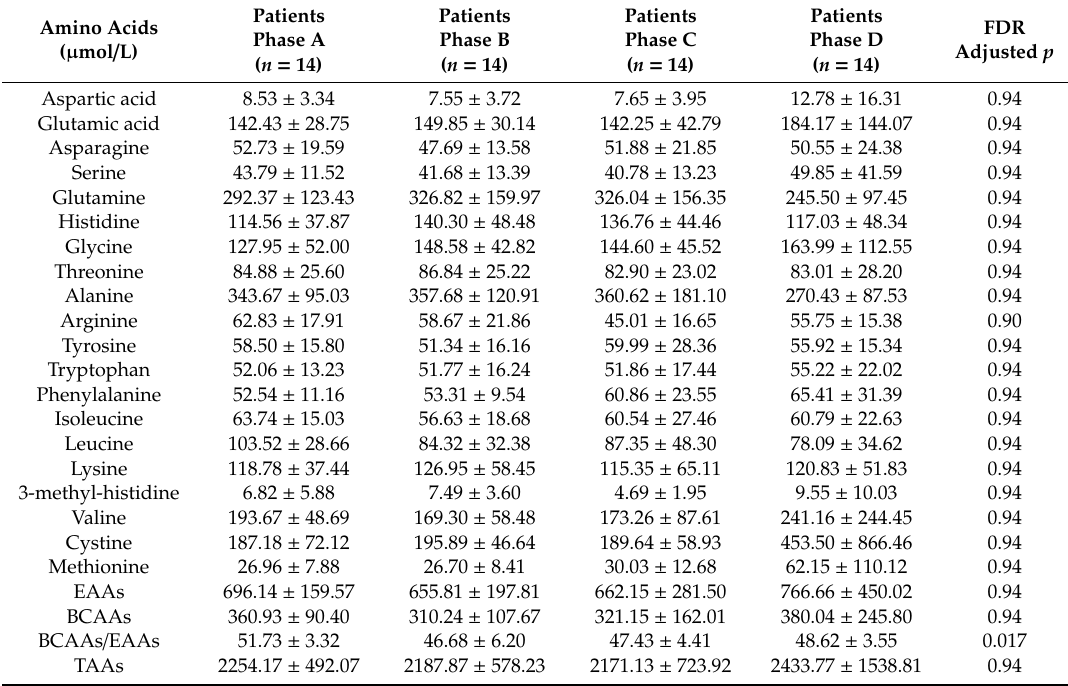
Table 3. Plasma amino acid concentrations ( µ mol / L) at each phase of chemotherapy (phase A = before; phase B = 1 month; phase C = 3 months and phase D = at the end of chemotherapy cycle—6 months). Amino Acids ( µ mol /